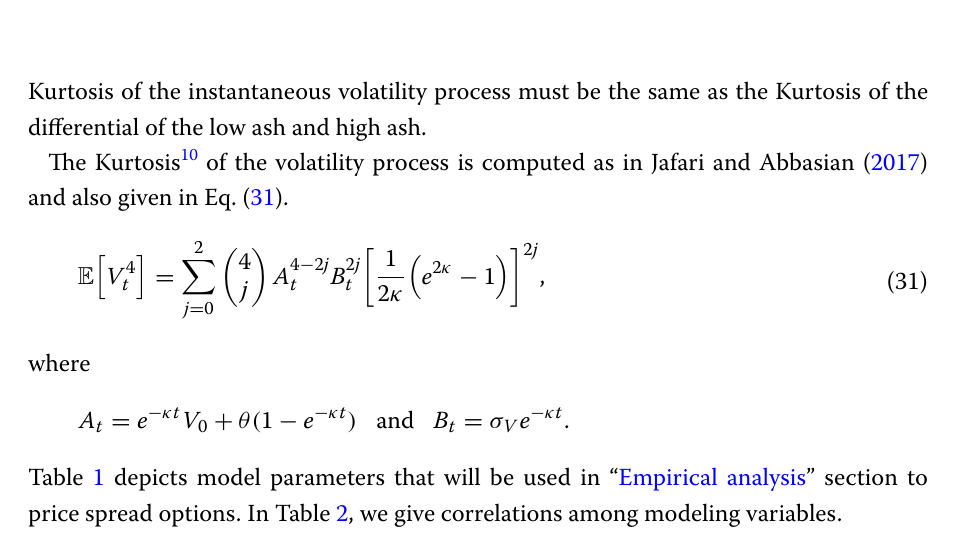
Fig. 2 Rolling correlation of the historical